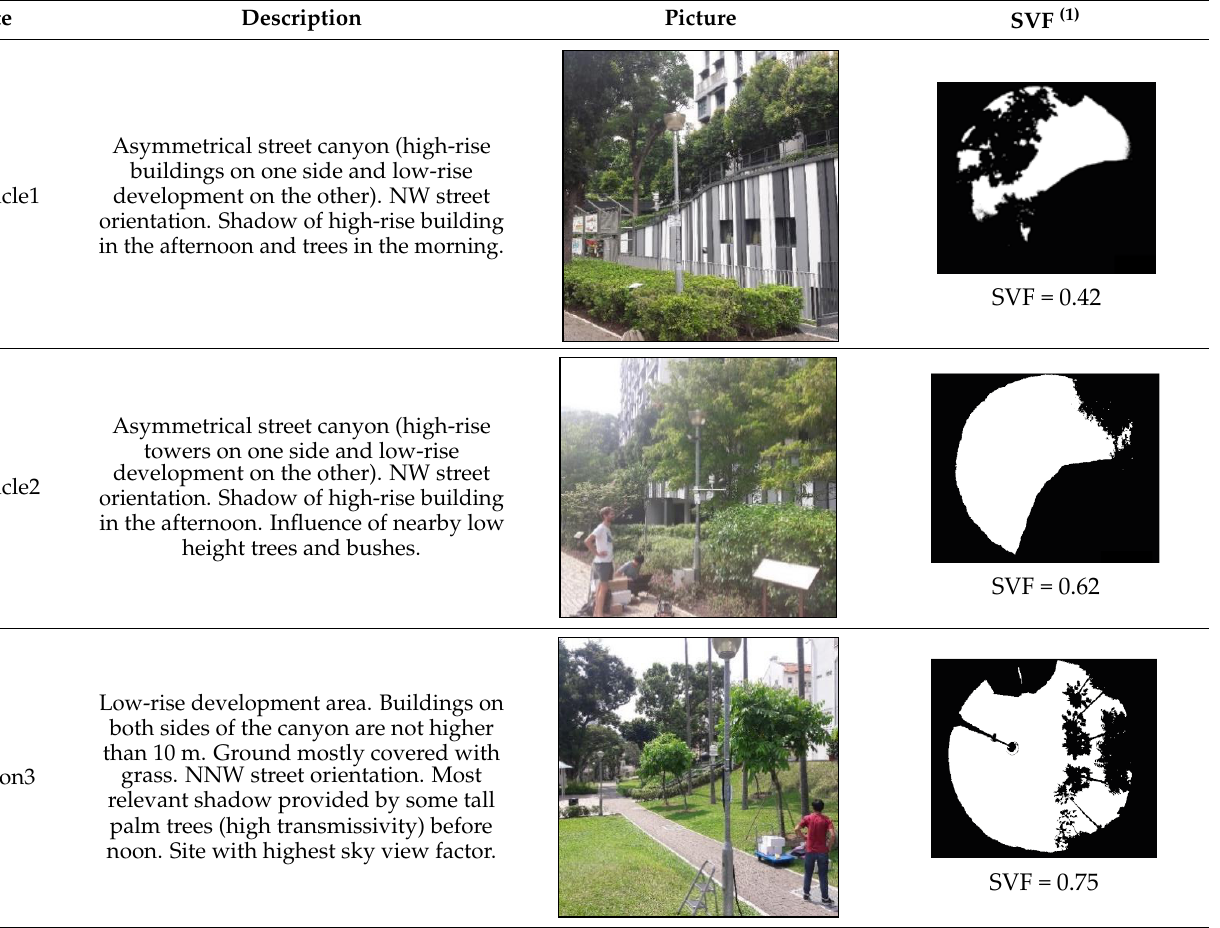
Figure 3. Location of the selected sites for the measurement campaign in the Duxton Park area. Table 1. Description of the sites in the Duxton Park area where measurements were carried out.